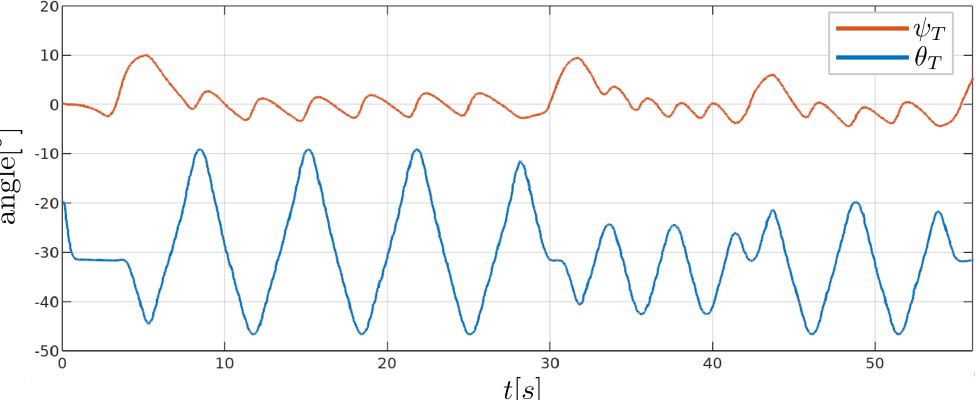
Figure 17. Spray frame orientation during the indoor experiment. The pitch and yaw angles of the spray frame are denoted as θ T and ψ T , respectively. These angles are not directly controlled, but are a result of the task space control criterion